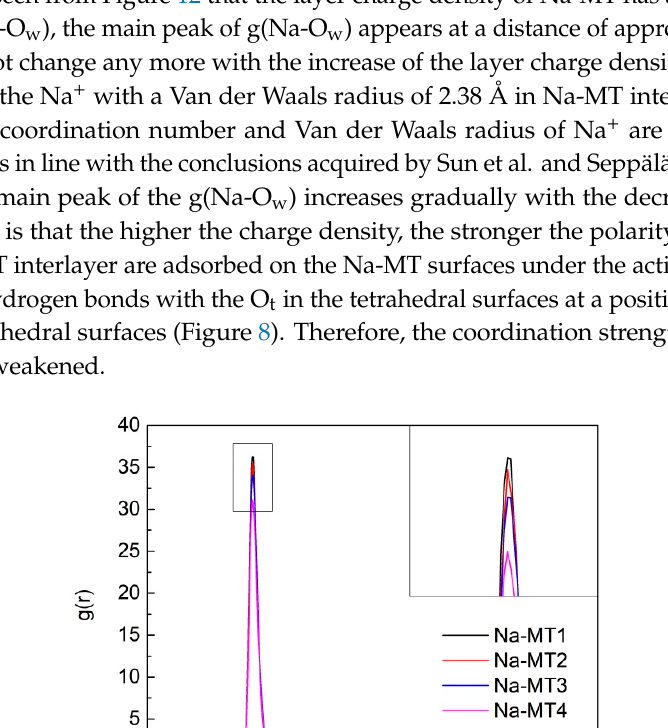
( d ) Figure 14. The RDF of Na-O w in Na-MT with different isomorphic substitution sites, ( a ) Na-MT1, ( b ) Na-MT2, ( c ) Na-MT3 and ( d ) Na-MT4. 4. Conclusion In this work, the influence of layer charge density and isomorphic substitution sites on the spatial distribution of H 2 O and Na + in the interlayer of Na-MT was investigated. The simulation results show that the distribution of H 2 O and Na + is significantly related to the crystal chemistry properties of Na-MT. In the interlayer domain of Na-MT, H 2 O are mainly distributed in the range of − 2.0 Å~+2.0 Å near the central axis, and when layer charge density increases, H 2 O tend to shift and